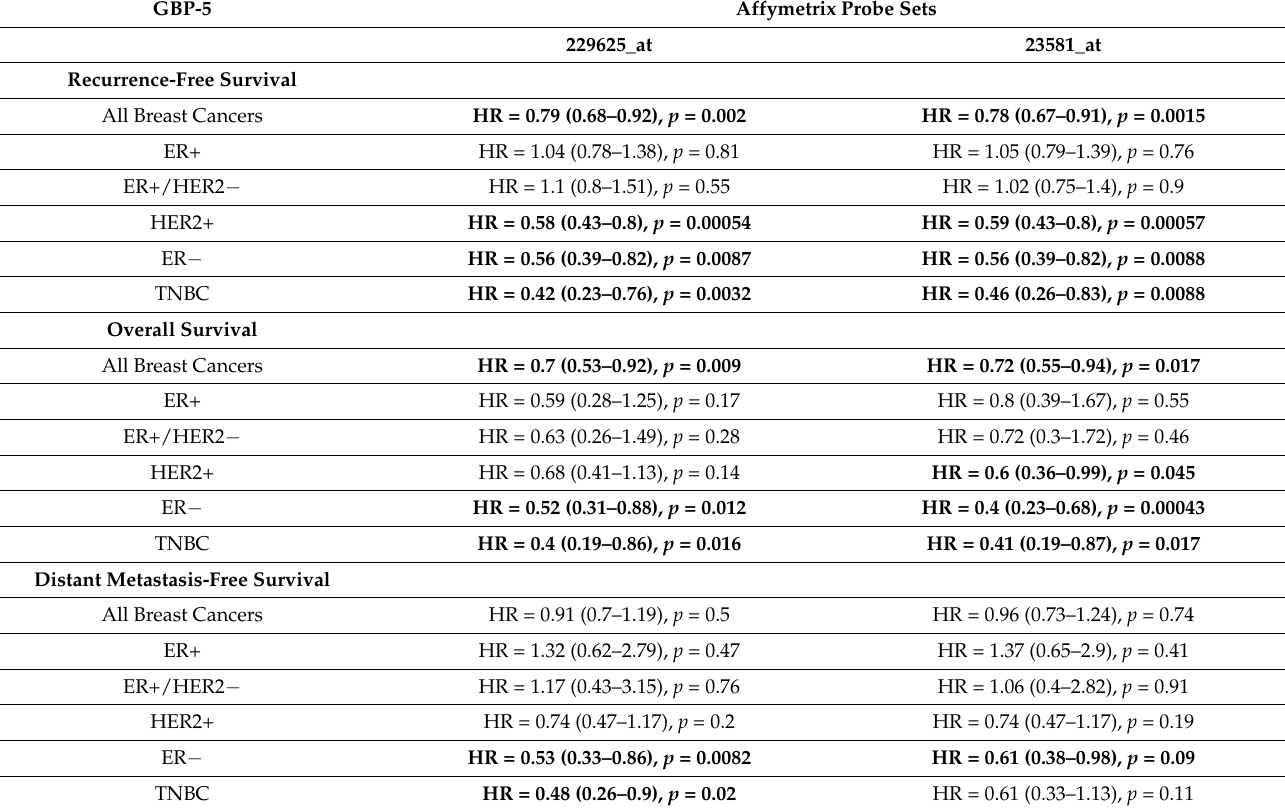
Table 5. Data from both GBP-5 probe sets of the HG-U133A Affymetrix microarray were analyzed for Recurrence-Free Survival (RFS), Overall Survival (OS), and Distant Metastasis-Free Survival (DMSF) using KmPlotter. All breast cancers included breast cancers of all histologies, hormone status, and grade. ER+ represents only those breast cancers positive for estrogen receptor but with any other hormone status. ER+/HER2 − contains the data from all ER+ breast tumors than were also HER2 − . There could be positive or negative for progesterone (PR). HER2+ tumors included those that were positive for HER2+ and had any other hormone receptor status. The data are presented as Hazard Ratio (HR) immediately followed by the HR. The range of numbers within the paratheses is the 95% confidence interval. p represents the LogRank p . Bold values are those that indicate that higher expression of GBP-5 significantly improves that